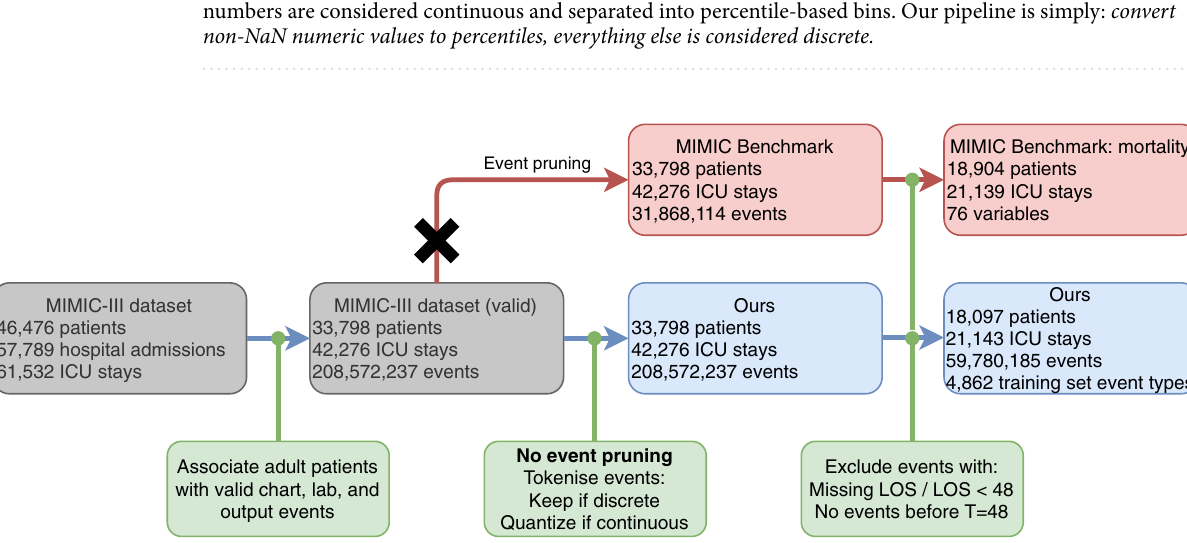
Figure 1. Patient and event summary statistics at each stage of our pipeline (blue) compared to the MIMIC-III benchmark (red). We replace event pruning with tokenisation, which leads to a broader set of variables making up a larger set of events. For one training split, there are 4862 event types, 3678 of which are continuous, leading to 31,913 possible variables when 10 percentile bins are used. In this diagram, ‘MIMIC Benchmark’ refers to the processing in Harutyunyan el al. 21